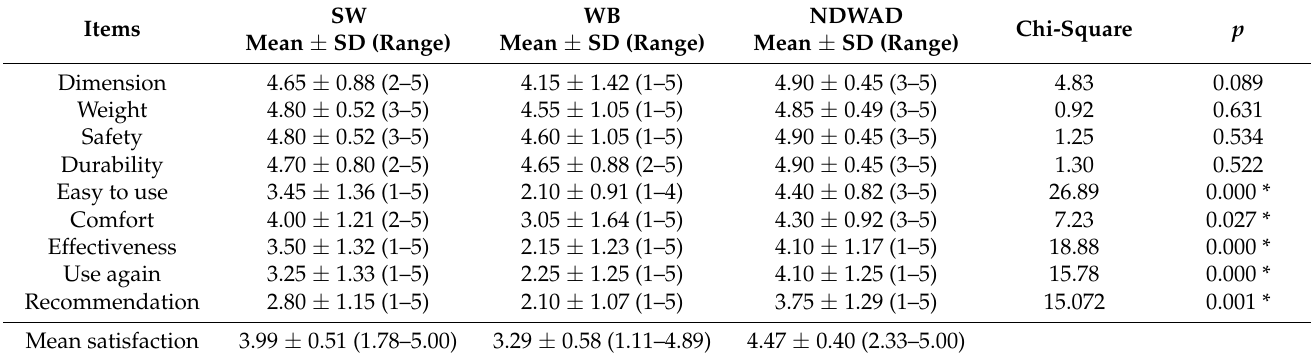
Table 8 and Figure 7 show the evaluation results of nine questions relating to satis- faction levels. In the SW section, ‘Weight’ and ‘Safety’ had the highest score, and ‘Rec- ommendation’ had the lowest score. In WB, ‘Safety’ had the highest score, while ‘Easy to use’ and ‘Recommendation’ had the lowest. For the NDWAD, ‘Dimension’, ‘Safety’, and ‘Durability’ received the highest scores, while ‘Recommendation’ received the lowest. The mean satisfaction score for all items was NDWAD (4.47), SW (3.99), and WB (3.29). There was a significant difference ( p < 0.05) in ‘Easy to use’, ‘Comfort’, ‘Effectiveness’, ‘Use again’, and ‘Recommendation’ among the nine items.